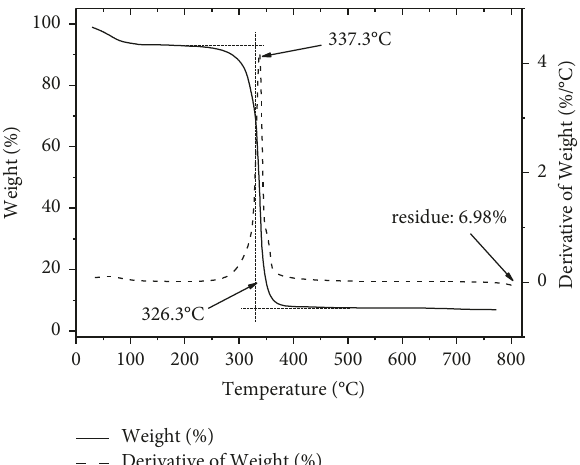
Figure 5: TGA result of the synthesized film (The raw data are available in the supplementary file (available